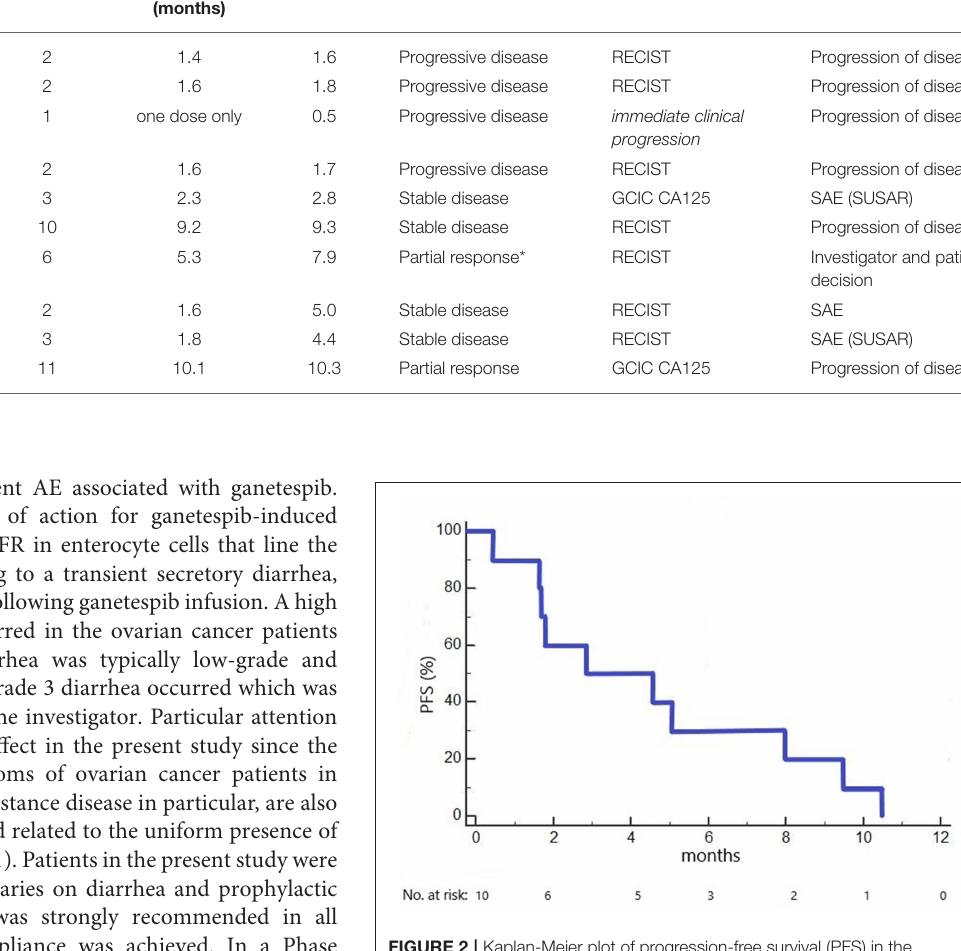
FIGURE 2 | Kaplan-Meier plot of progression-free survival (PFS) in the GANNET53 Phase I trial. All 10 patients included experienced disease progression (no censored